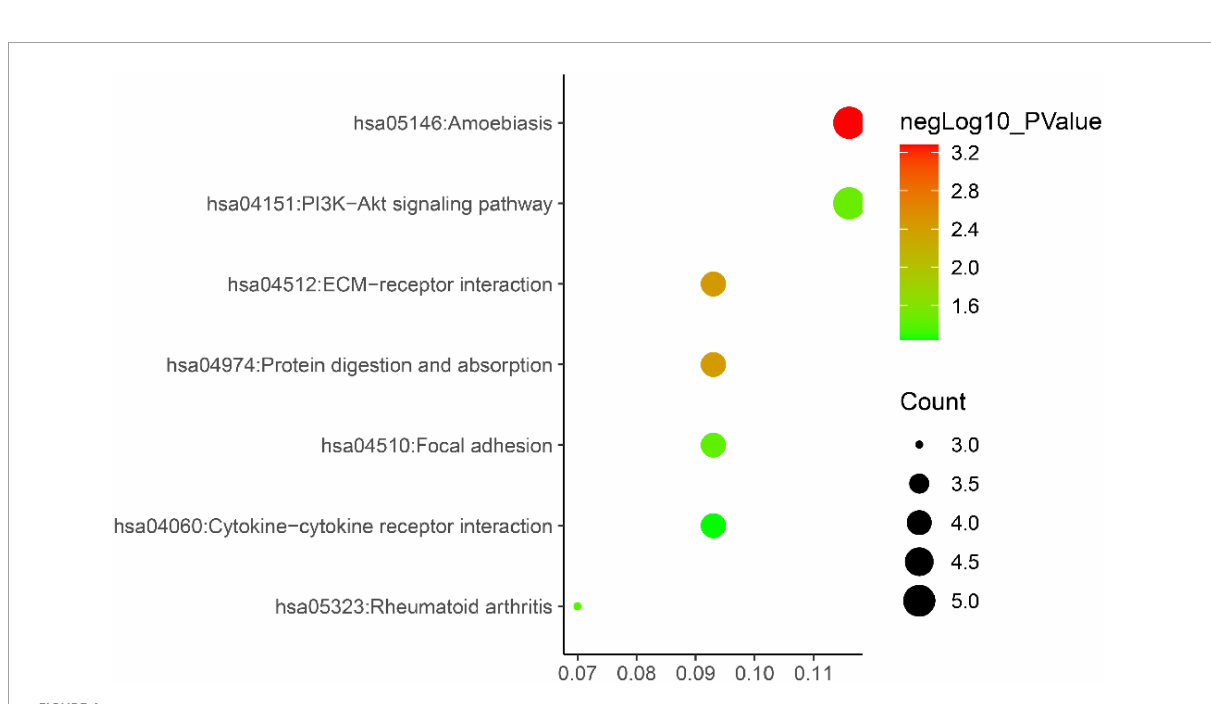
FIGURE4 KEGG pathway enrichment